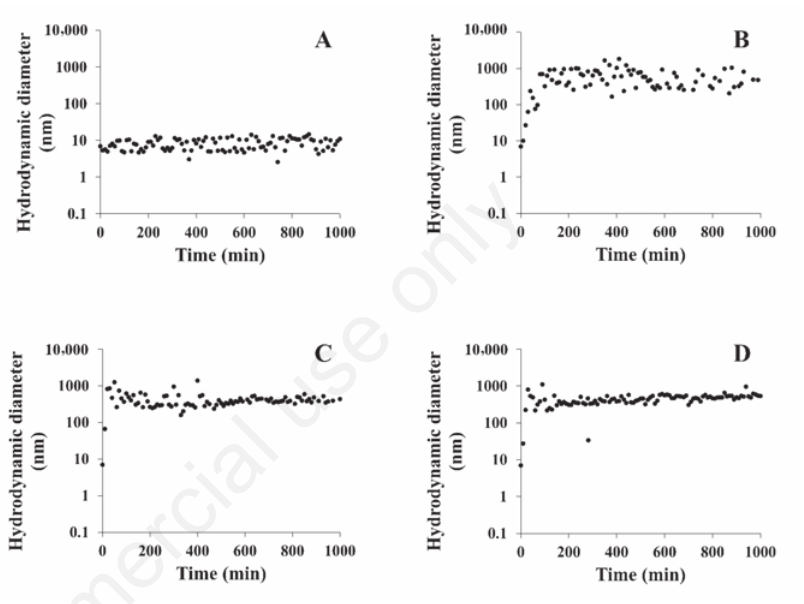
Figure 1. Aggregation kinetics of silver nanoparticles at 93